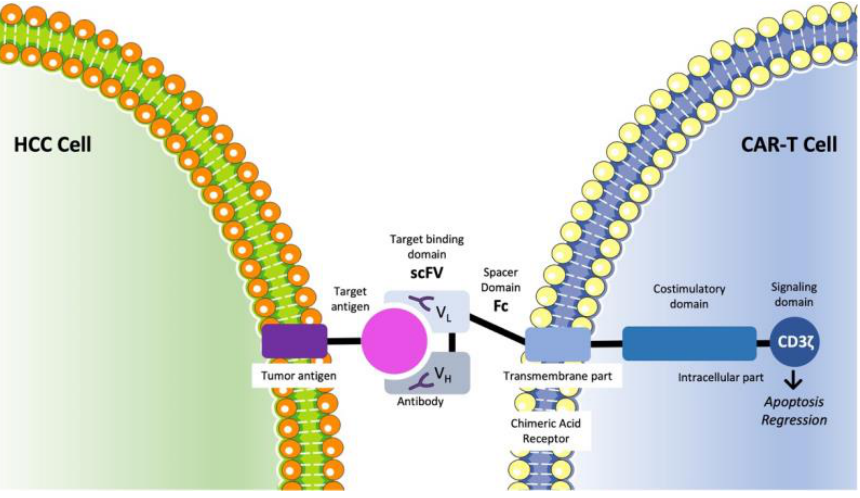
Figure 7. Mechanism of action of CAR-T cell therapy for the treatment of HCC.